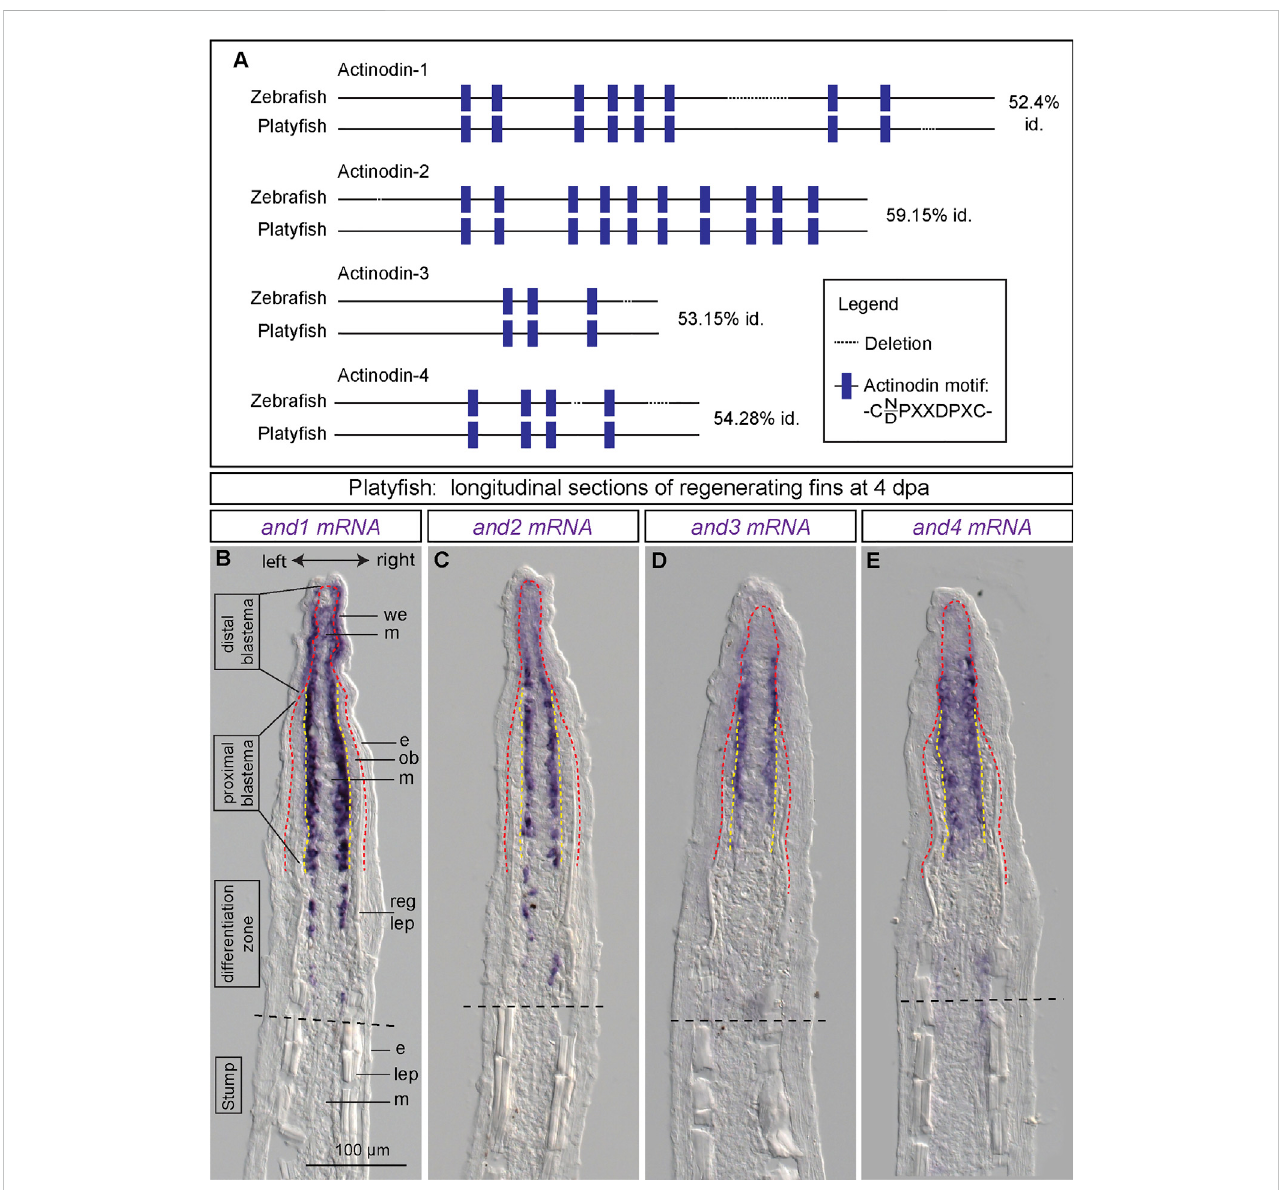
Identi fi cation of four actinodin genes in platy fi sh and their expression in the regenerative outgrowth. (A) Schematic alignment of actinodin orthologs in thezebra fi shandtheplaty fi sh,identi fi edbasedontheBLASTtool atNCBI,usingthezebra fi sh annotatedproteinsasquery.Identity(id)represents percentage of the conserved amino acids in the protein sequence. (B – E) In situ hybridization of actinodin genes in the platy fi sh fi n sections at 4 dpa. (N = 3 fi sh). Black dashed lines indicate amputation planes. Red dashed line depicts the boundary between the wound epidermis and the underlying tissue. Yellow dashed line depicts the boundary between the osteoblast layer and mesenchyme. We, wound epidermis; m, mesenchyme; e, epidermis; ob, osteoblasts; reg lep, regenerating lepidotrichia; lep,